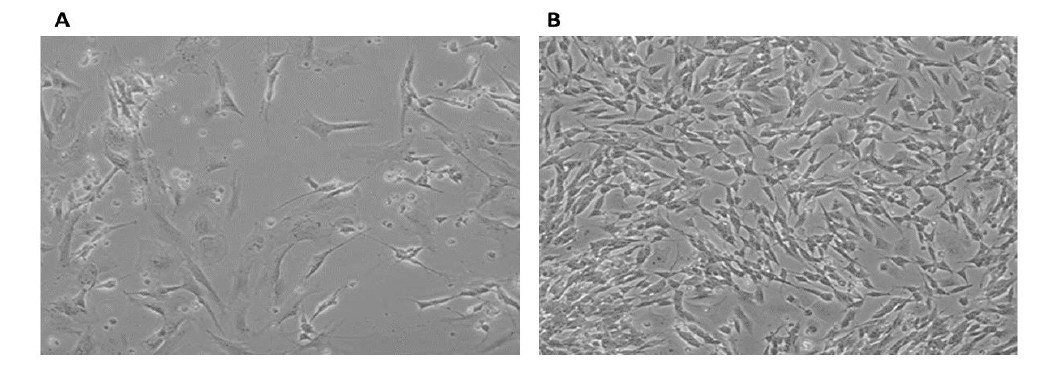
Figure 2: SH-SY5Y cell with and without all-trans retinoic acid treatment: At day-8 after ATRA treatment (A) and without ATRA treatment (B) at 10X magnification. Cells with ATRA are observed to be sparse in number, have larger cell bodies and longer neurites. Cells without ATRA have propagated in